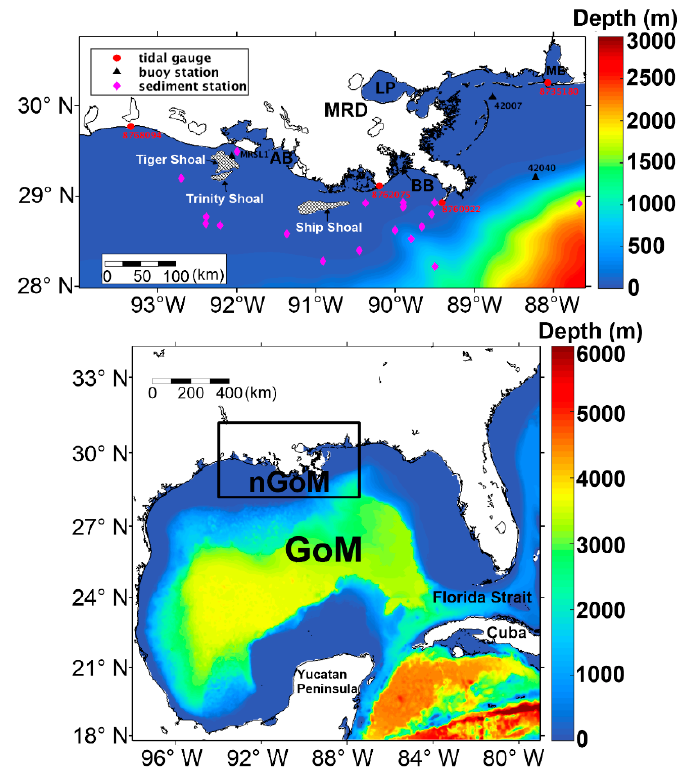
Figure 1. The northern Gulf of Mexico (nGoM; upper panel) and Gulf of Mexico (GoM; lower panel) grid domains used in the Regional Ocean Modeling System (ROMS) and the Simulating Waves Nearshore model (SWAN), overlaid with water depth (color-shading; ETOPO1), locations of tidal gauges (red circle), buoy stations (black triangle), sediment stations (magenta diamond), and shoals. (AB: Atchafalaya Bay; BB: Barataria Bay; MRD: Mississippi River Delta; MB: Mobile Bay; LP: Lake Pontchartrain).